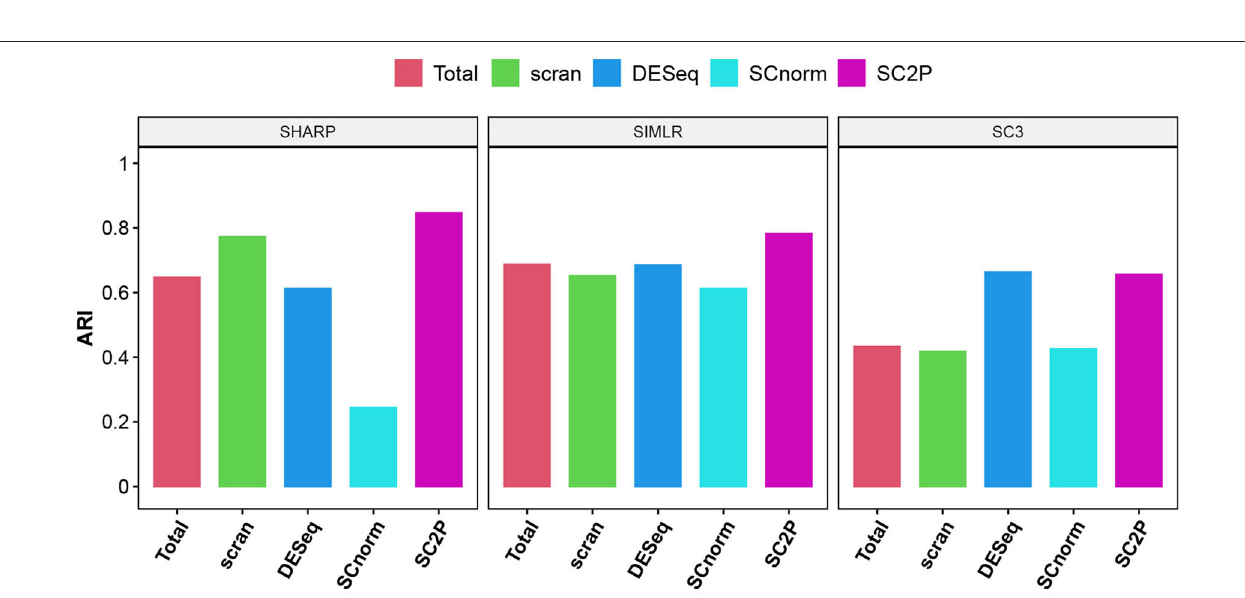
Frontiers in Genetics |